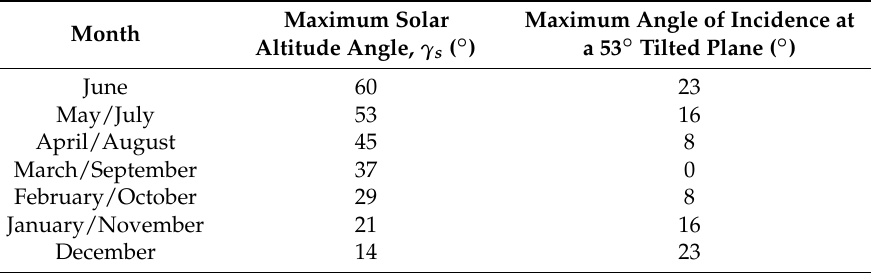
Table 3. Optimum tilt angles and angles of incidence at a tilted plane in